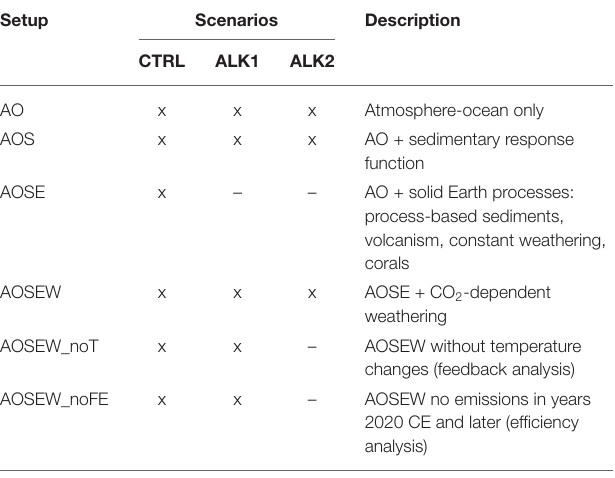
TABLE 1 | Compilation of simulated scenarios and setups.